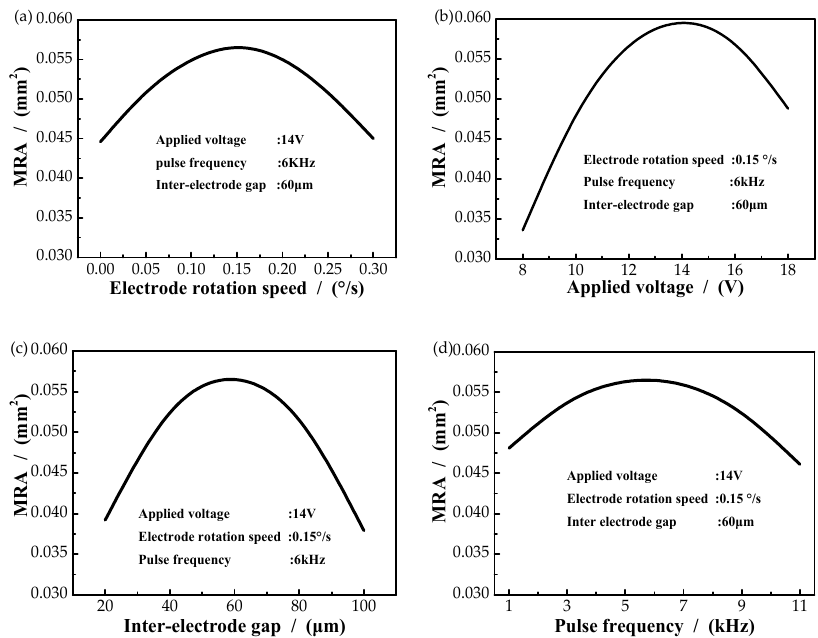
Figure 2. Main effects of process parameters on MRA. ( a ) Electrode rotation speed; ( b ) Applied ( c )Interelectrode gap; ( d )Pulse voltage; ( c )Interelectrode gap; ( d )Pulse frequency.